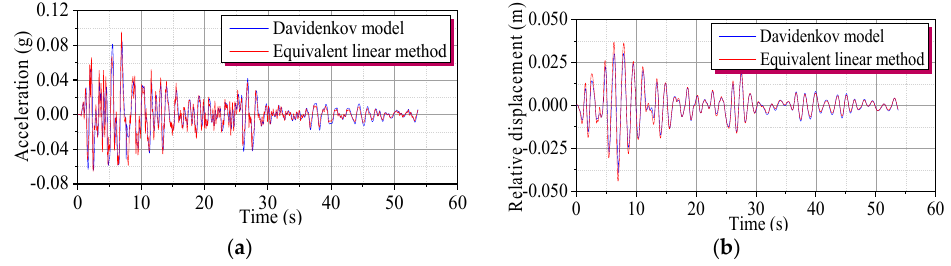
0 Figure 7. Comparison of ( a ) ground surface acceleration time history responses and ( b ) ground surface relative displacement responses. Table 2. Comparison between the Davidenkov model and equivalent linear method results.